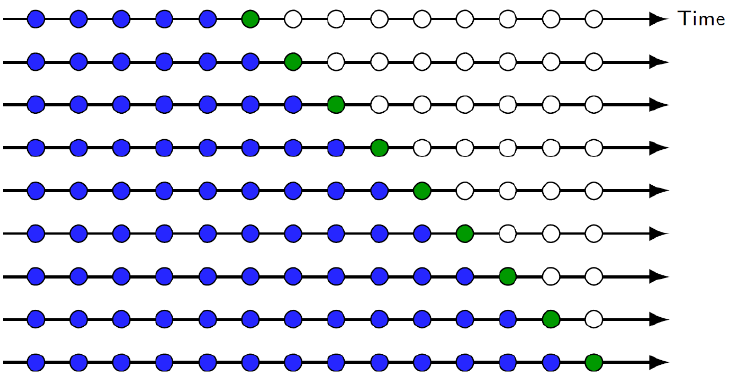
Figure 10. TSCV for one-step-ahead forecasting. The blue dots refer to the training set while the green dots refer to the test set. The sampling distribution of an error statistic is estimated over a sequence of constructed train-test partitions.